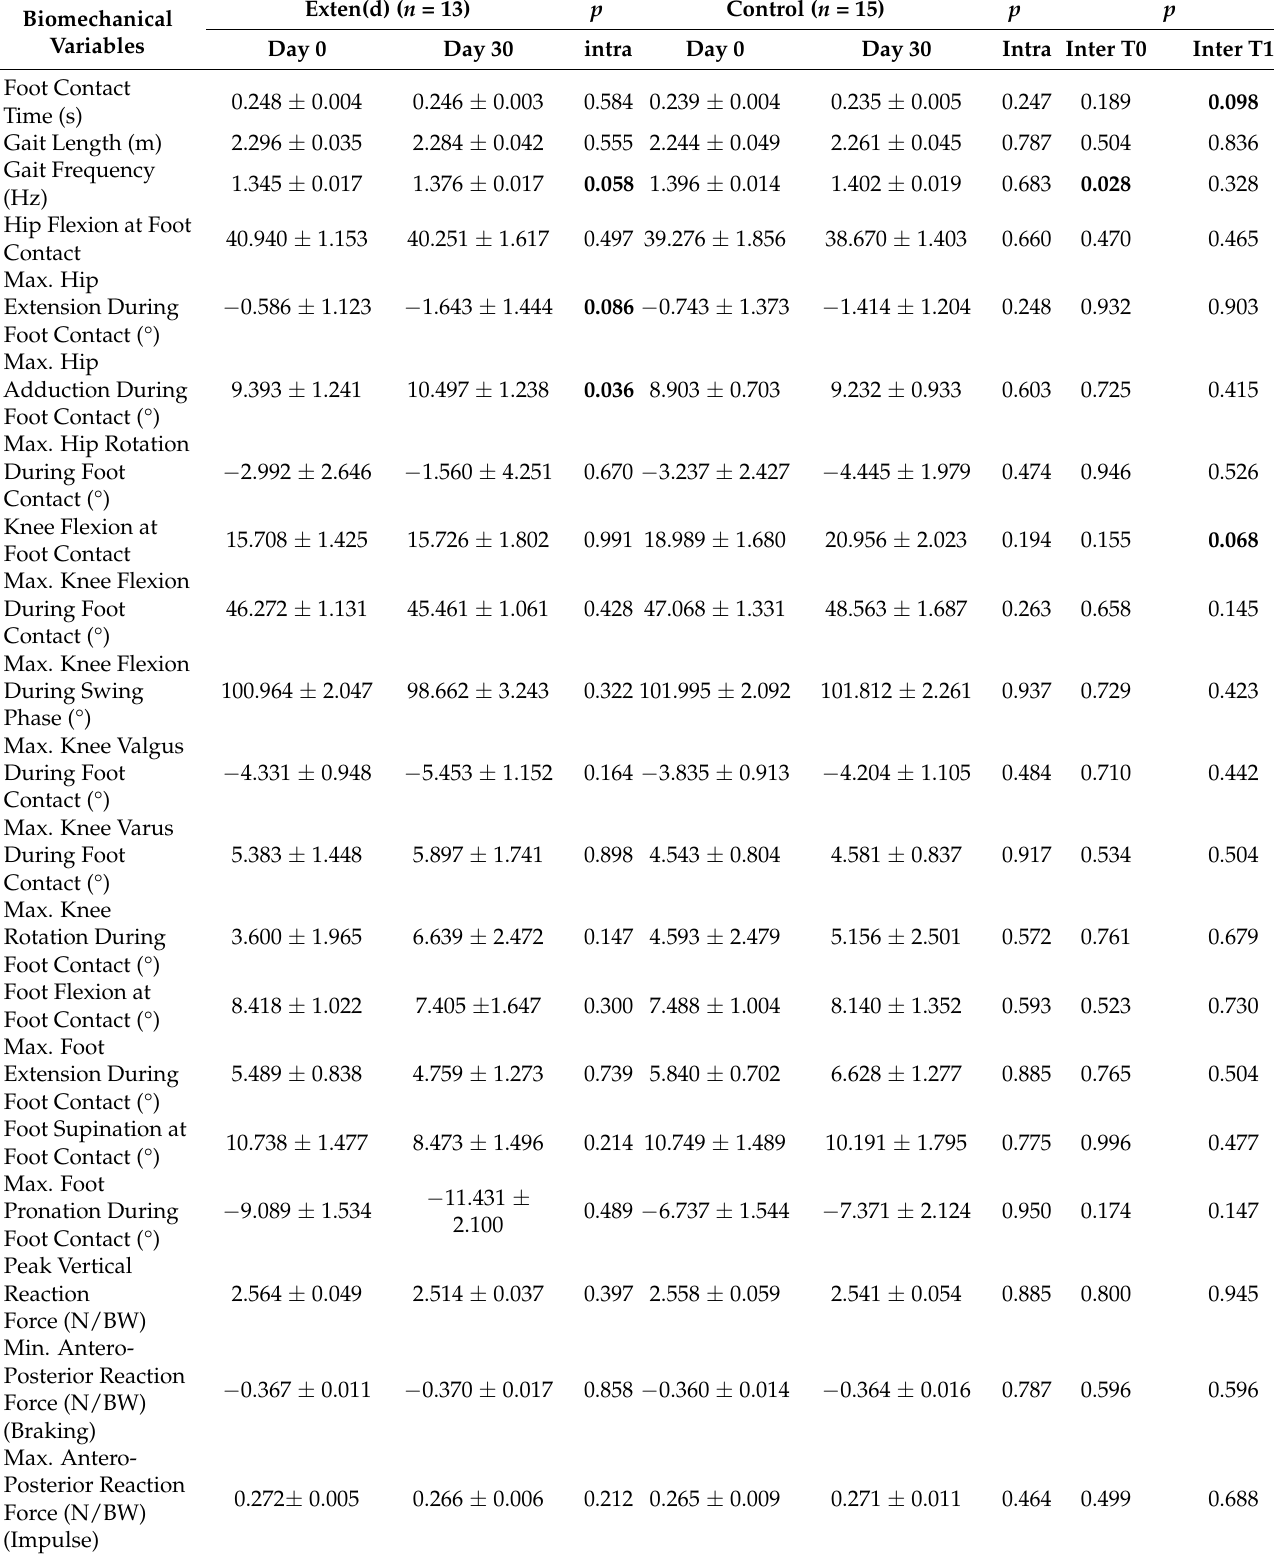
Table 3. Changes in biomechanical variables after exercise on a treadmill before and after supplementation.